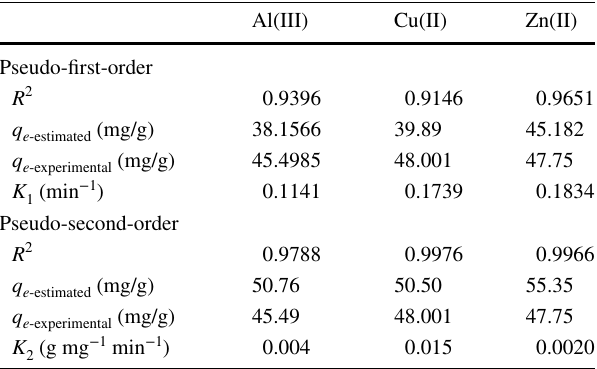
Table 3 Kinetics parameters for the adsorption of Al(III), Cu(II) and Zn(II) on MZNCs at pH = 5 for (Al), pH = 6 for (Cu and Zn) and 27